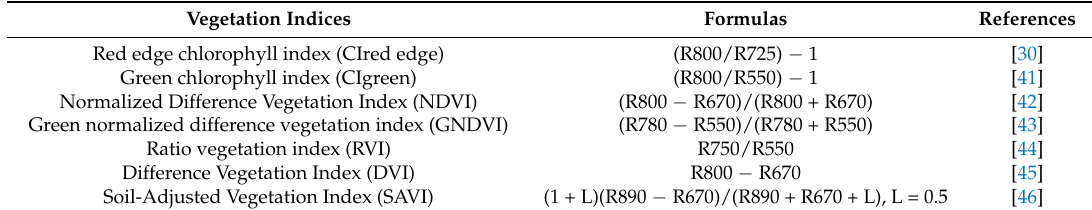
Table 3. Vegetation indices (VIs)